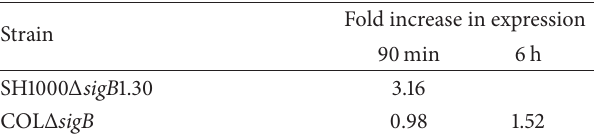
Table 3: Expression levels of msrA1 in sigB mutants relative to wild- type S . aureus strains SH1000 and COL. Fold increase in expression Strain 90min 6 h SH1000 Δ sigB 1.30 3.16 COL Δ sigB 0.98 1.52 Values indicate averages of three independent experiments. Table 4: Induced expression of msrA1/msrB locus genes in S. aureus strain COL under oxacillin stress. Gene Fold increase in expression under oxacillin stress msrA1 22.9 msrB 18.97 IIa(PTS) 13.45 Values indicate averages of three independent experiments. Figure 5: Analysis of msrA1/msrB promoter- lacZ fusion in S. aureus COL in response to oxacillin. Bacterial culture was grown in TSB to OD 600 = 0.3 and then exposed to oxacillin (0.4 and 1.0 mgmL −1 , resp.) for 2h. Subsequently, cells were collected via centrifugation and the 𝛽 -galactosidase activity was determined. Values indicate averages of data from at least three independent experiments ± standard error ( ∗ significant at 𝑝 ≤ 0.05 ).